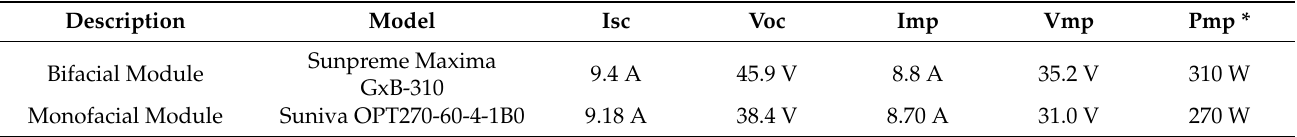
Table 1. Module factory rated specifications.